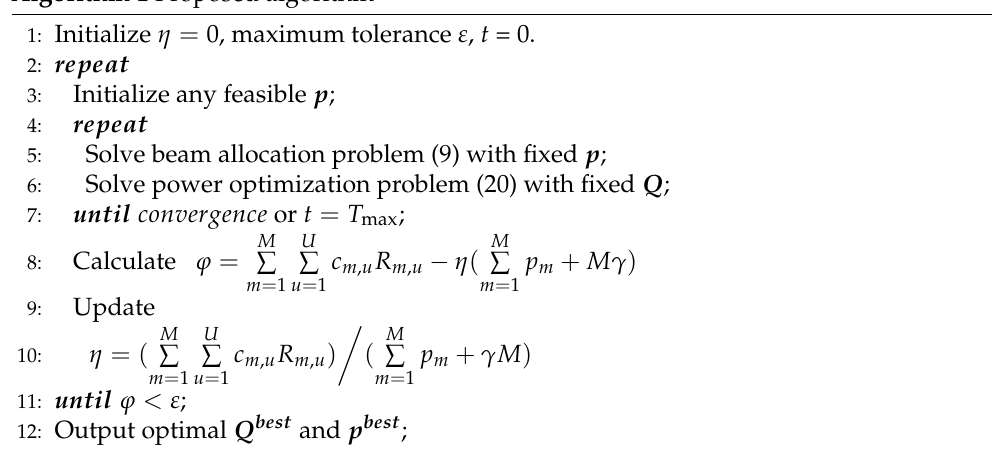
Algorithm 1 Proposed algorithm